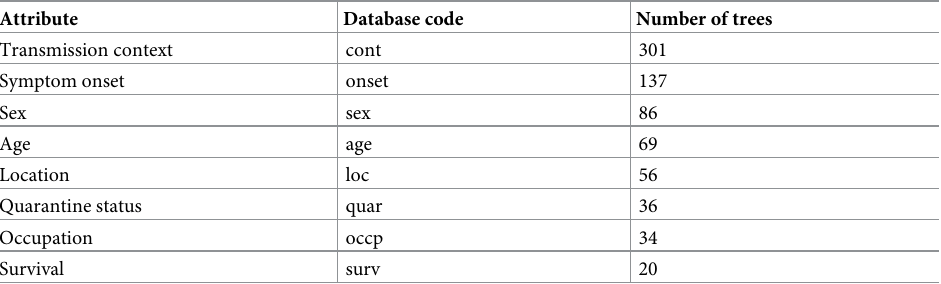
Table 1. List of most common attributes for individuals in